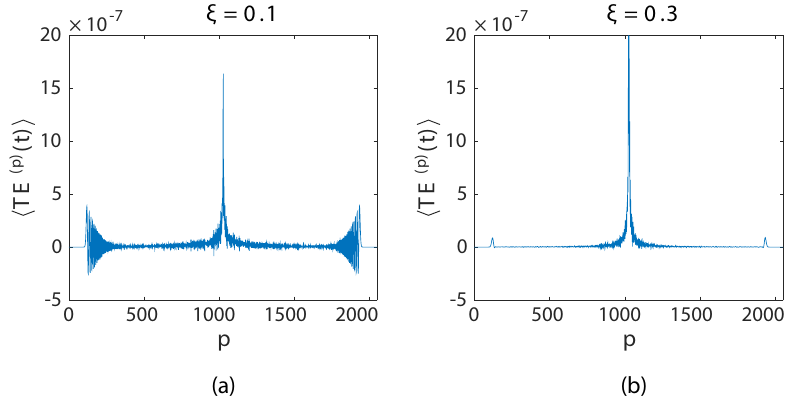
Figure 8. ( a ) The center pulse ( p = 1025) is imparted with v o = 0.01 initially towards the right. ( b ) The total energy signal is averaged over 500 ensembles at t ∼ = 750.